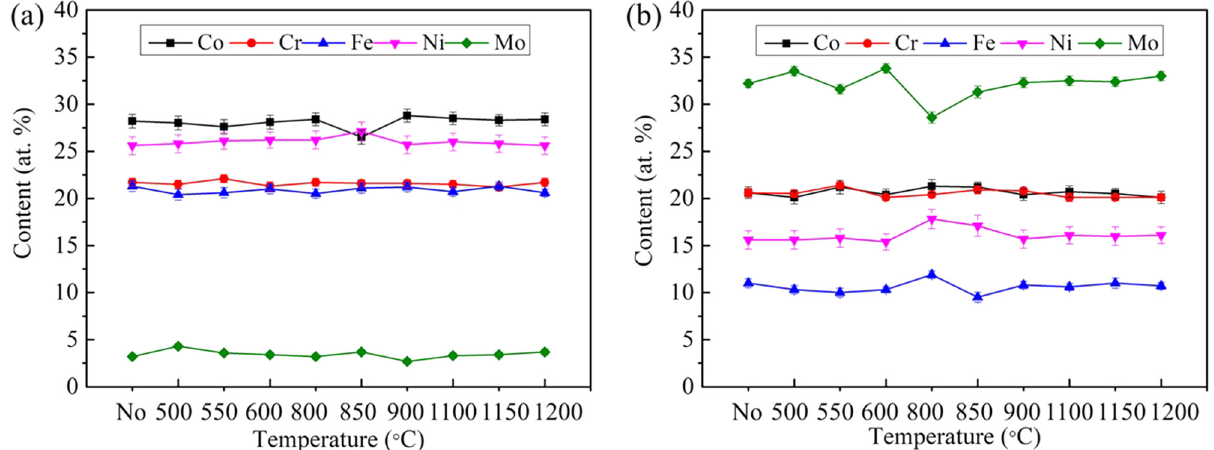
Figure 9: Chemical composition of di ff erent phases in the as - sintered and as - annealed Co 28.5 Cr 21.5 Fe 20 Ni 26 Mo 4 MEAs: ( a ) FCC phase and ( b ) μ